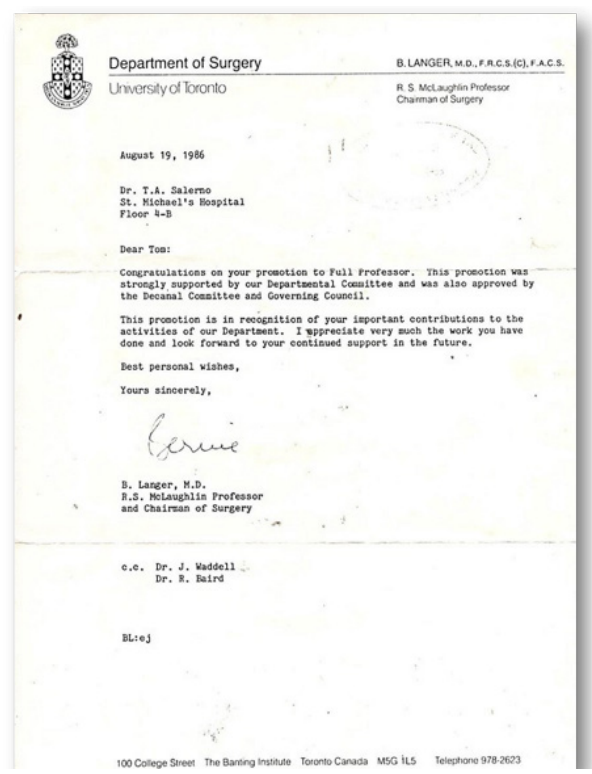
Fig. 8 - Letter from Dr. Bernard Langer to Dr. Tomas A. Salerno communicating the position of Full Professor of Cardiovascular Surgery.